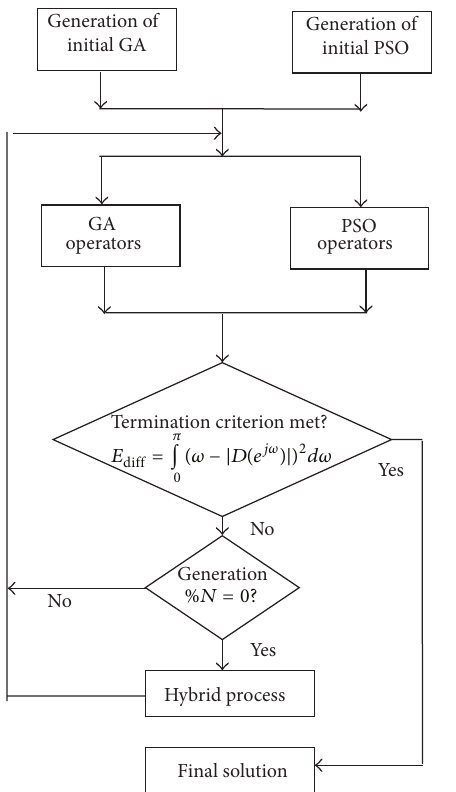
Figure 3: Flowchart of PSO-GA hybrid algorithm.